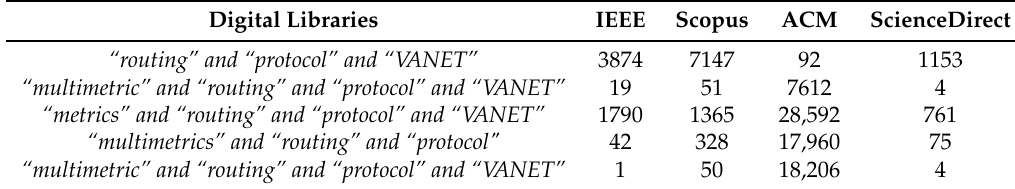
Table 2. Rresearch results using Boolean